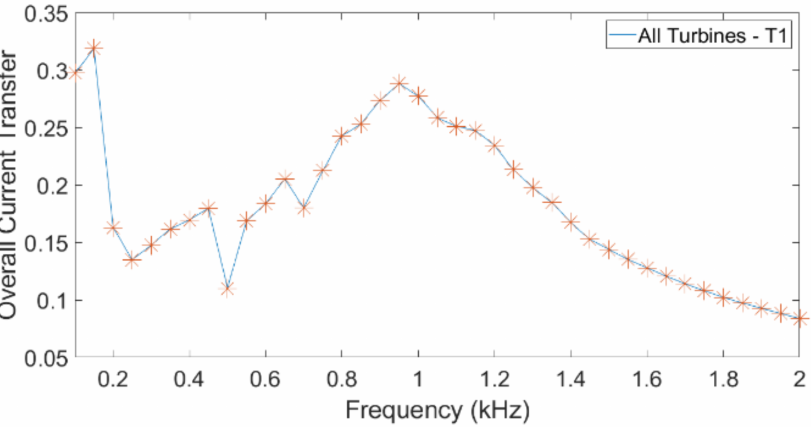
Figure 8. Overall current transfer between turbines: 42-turbine